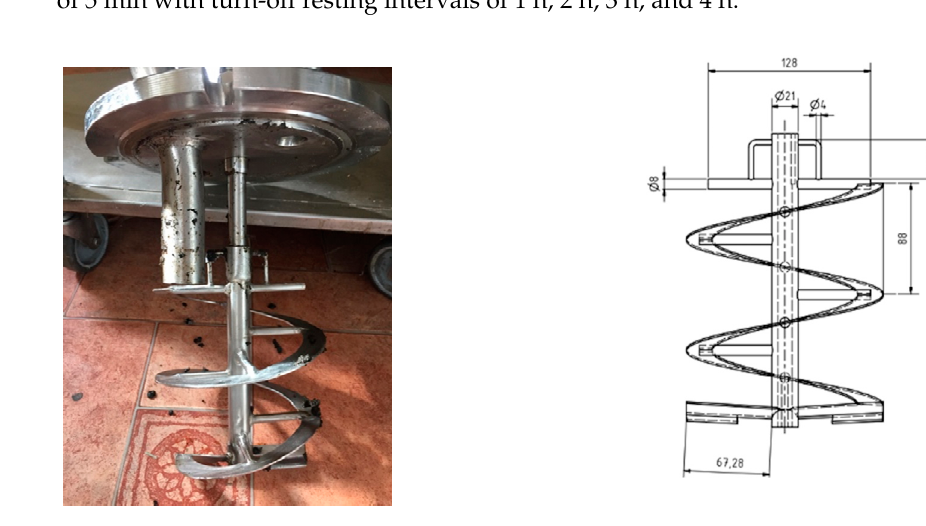
Figure 2. The geometry of the helical ribbon impeller used in this study.